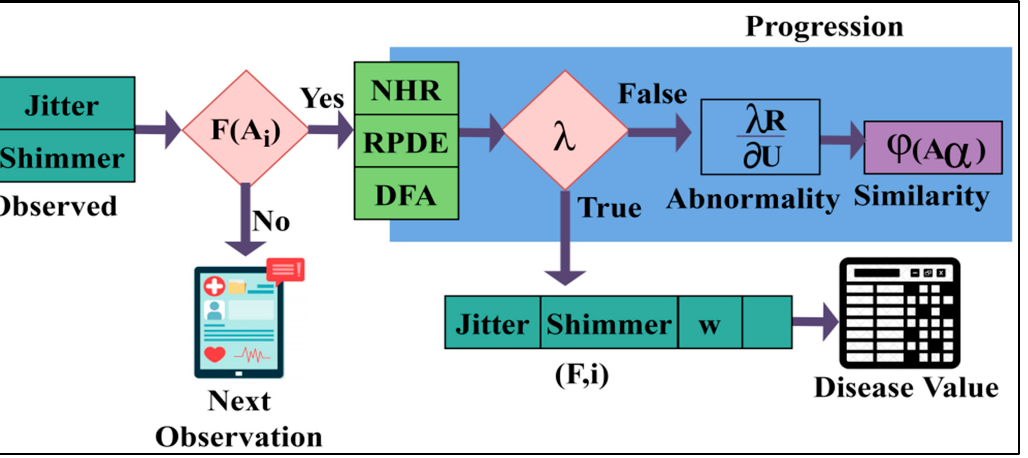
Figure 9. Progression classification.